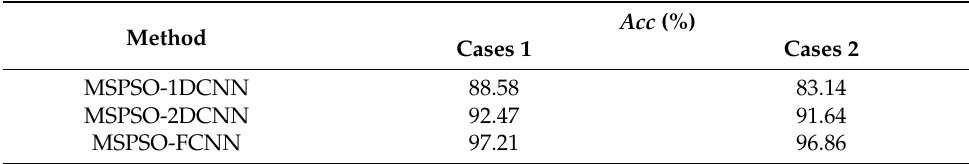
Table 7. Robustness comparison of different models.